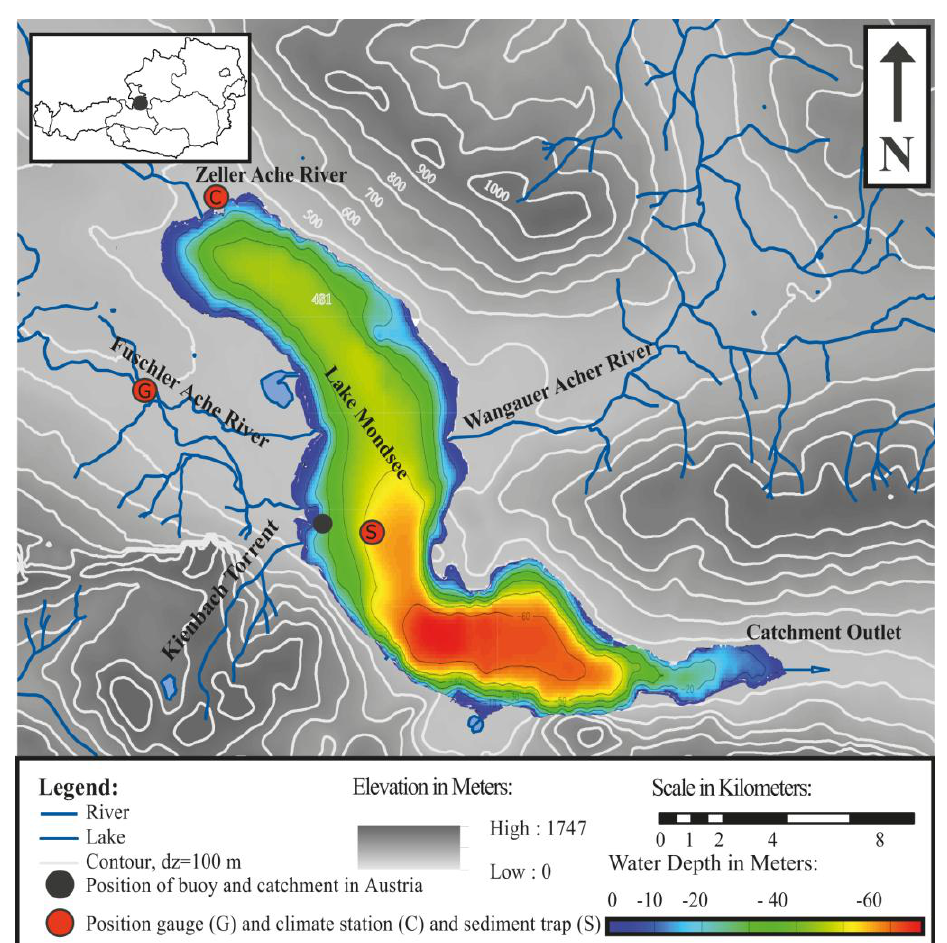
Figure 3. Map of Lake Mondsee and buoy position for test deployment. (C) Meteorological gauge operated by the ZAMG (Austrian Meteorological Survey). (G) Hydro-sedimentological gauge at the catchment outlet. (S) Position of the sequential sediment trap. The big black dot on the bathymetric lake map stands for position of the buoy during test deployment. The small black dot in the upper left corner shows the study site relative to the map of